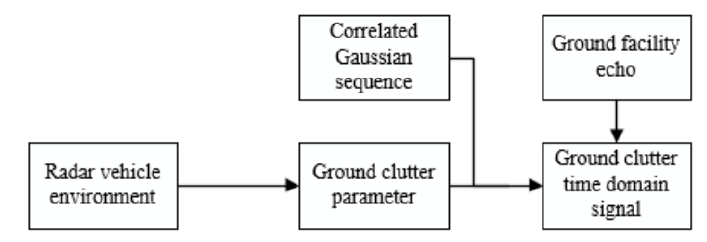
Figure 11. Simulated flow of ground clutter.